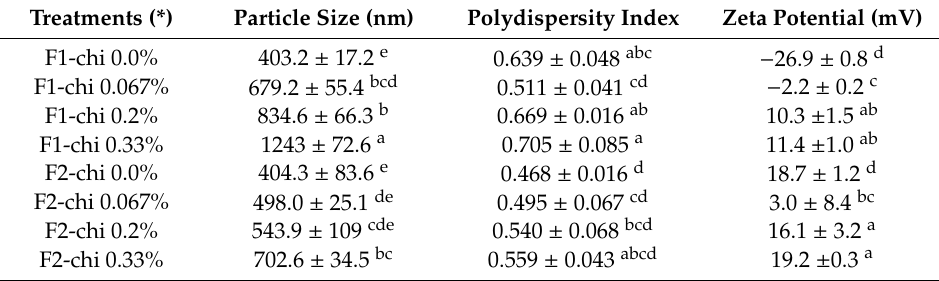
Table 3. Particle size, polydispersity index, and zeta potential of powders.